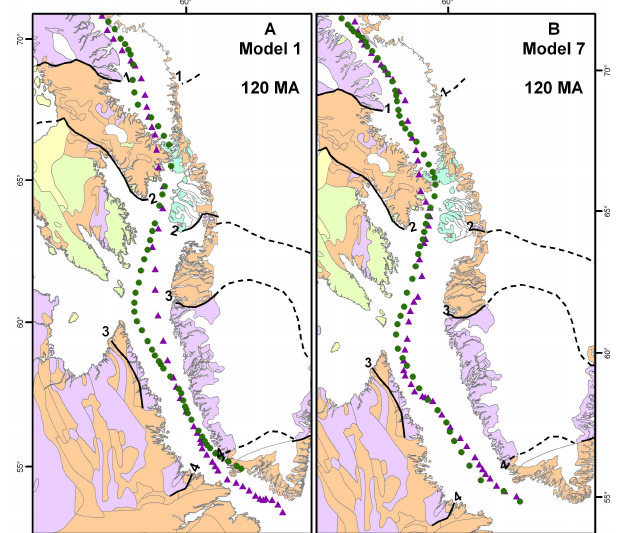
Fig. 13. Full-fit (120Ma) plate reconstruction of North America– Greenland margins. North America restored COB – green circles; Greenland restored COB – purple triangles. (A) Model 1 results in a major overlap in the northern Labrador Sea near Davis Strait. (B) Model 7 minimises the mismatch in this area and results in a good fit in both the Labrador Sea and Baffin Bay. Structural lines are the same as Fig. 11 and are represented here to show the lateral juxtaposing of the margins.